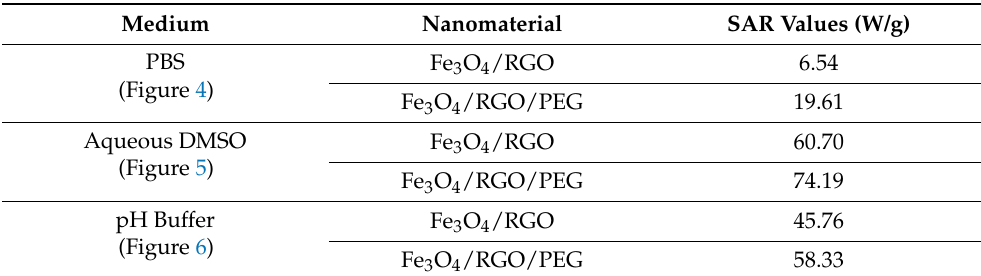
Table 1. SAR values of Fe 3 O 4 /RGO nanocomposites in different media at 1.6 mg/mL concentration subjected to a magnetic field at 200 A.